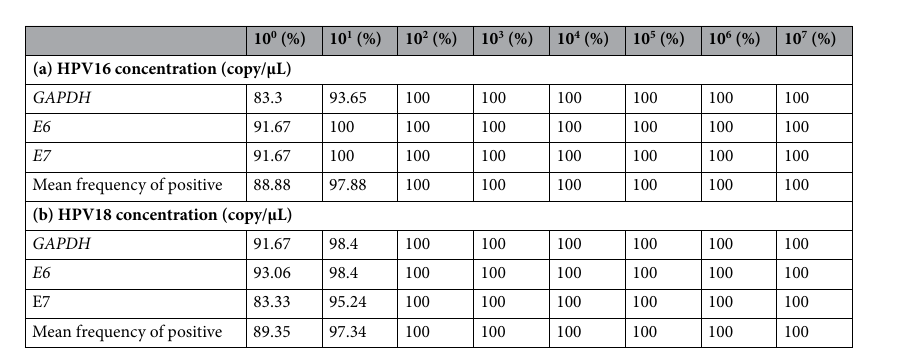
Table 4. Positive frequency for multiplex with plasmid serial dilution (10 7 –10 0 copies/µL). Positive frequency was calculated according to the ratio between the numbers of positive amplification detection and the number of expected amplification curve for each dilution of HPV16 (a) and HPV18